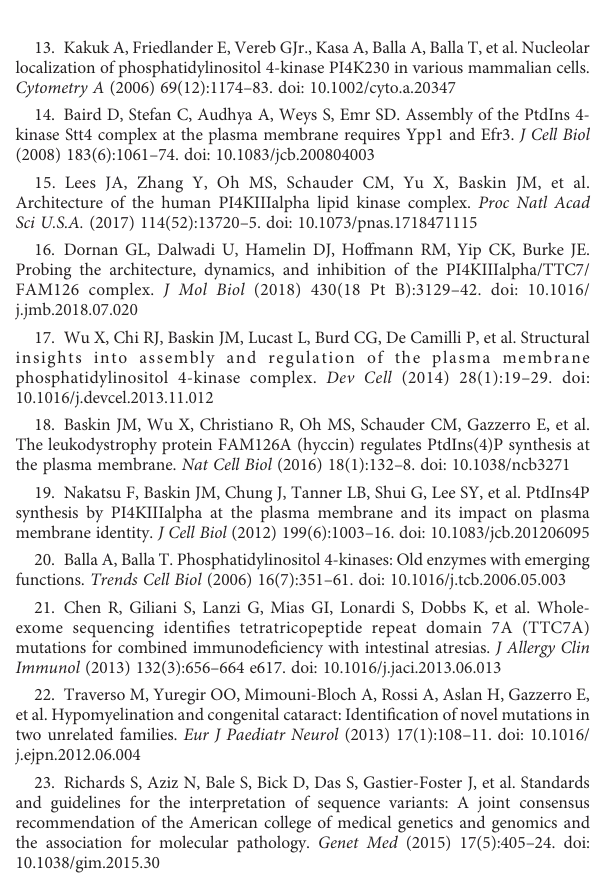
SUPPLEMENTARY FIGURE 1 The entire pathogenesis and treatment process. SUPPLEMENTARY FIGURE 2 Data interpretation pipeline for whole exome sequencing. SUPPLEMENTARY FIGURE 3 Splicing study by minigene assay. The agarose gel electrophoresis was applied for detecting the wild-type fragment 441 bp and the mutation type 436